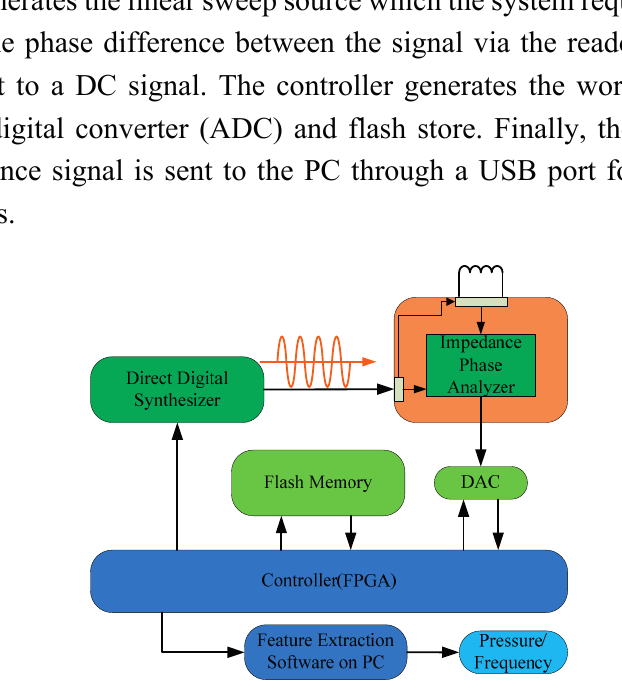
Figure 5. Block diagram of the conditioning